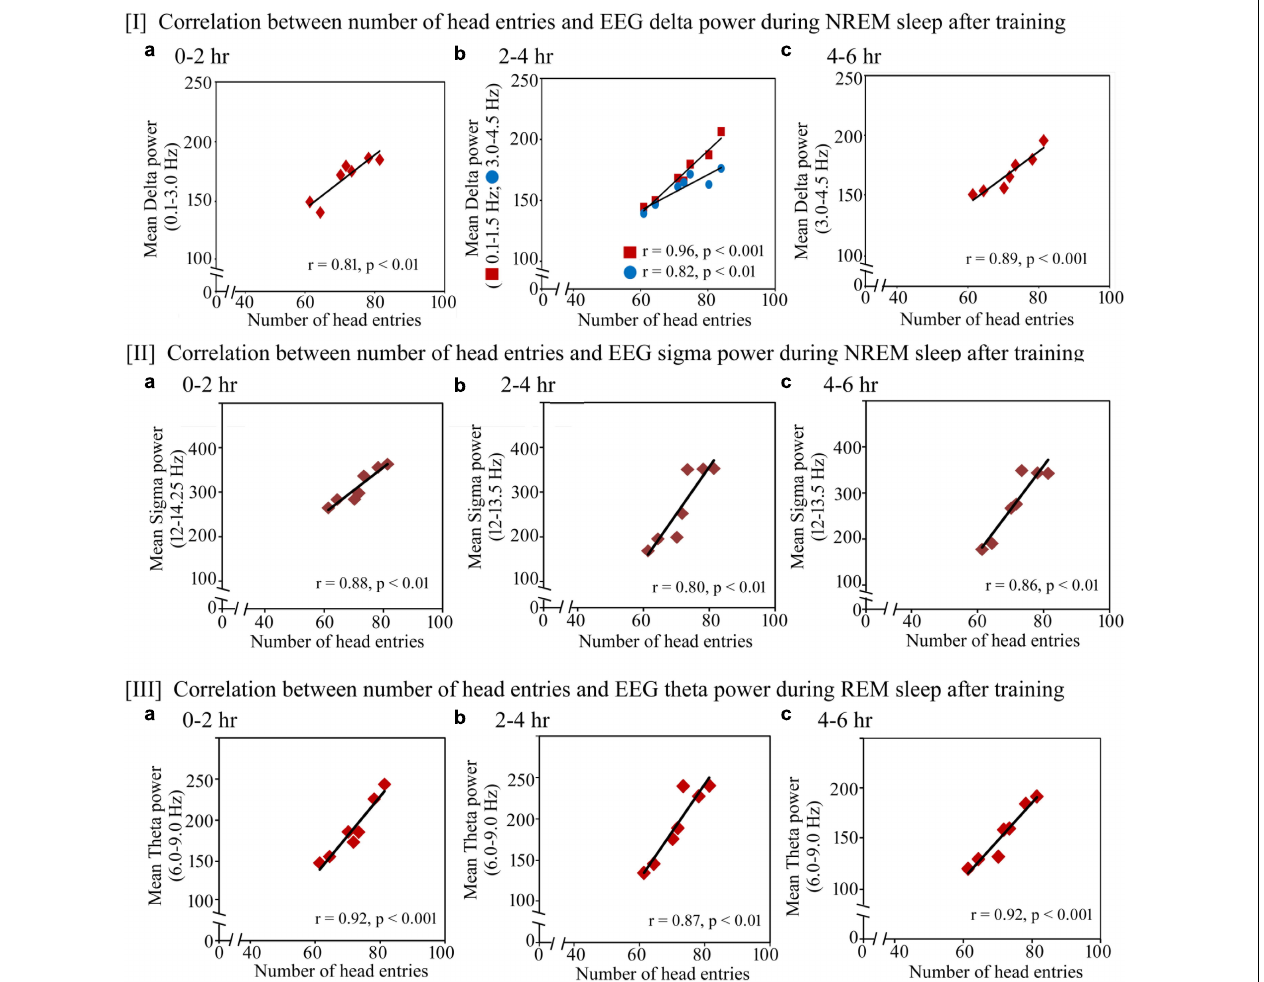
FIGURE 7 | Pearson correlation between performance and percent change in cortical oscillatory waves during NREM and REM sleep during the training day. On the training day, (I) the number of head entries significantly positively correlated with the increased power of SWA in the range of 0.1–3 Hz ( r = 0.81; p < 0.01) at 0–2 h (a) ; 0.1–1.5 Hz ( r = 0.96; p < 0.001) and 3–4.5 Hz ( r = 0.82; p < 0.01) at 2–4 h (b) ; and 3–4.5 Hz ( r = 0.89; p < 0.001) at 4–6 h (c) ; (II) the increased power in sigma waves during NREM sleep also significantly positively correlated with performance in the range of 12–14.25 Hz at 0–2 h ( r = 0.88; p < 0.01) (a) and in